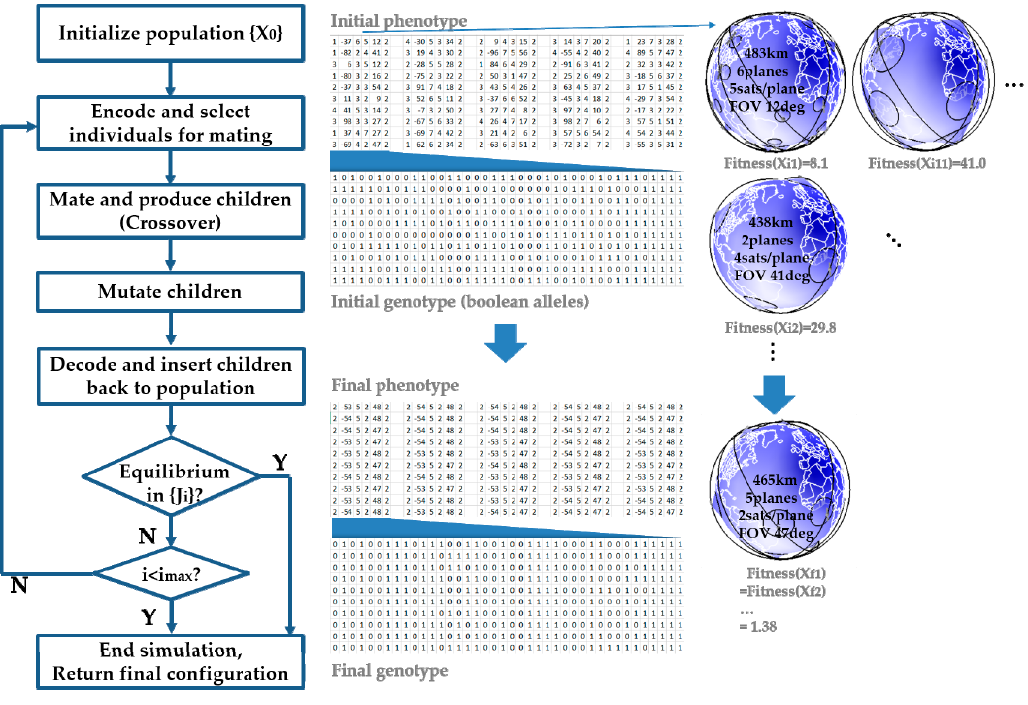
Figure 12. Genetic algorithm (GA) for ReCon optimization. Table 15. Range and initial value of design variables in